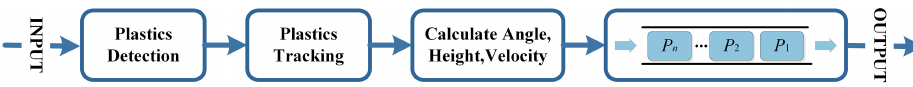
Figure 1. The process of plastics detection.